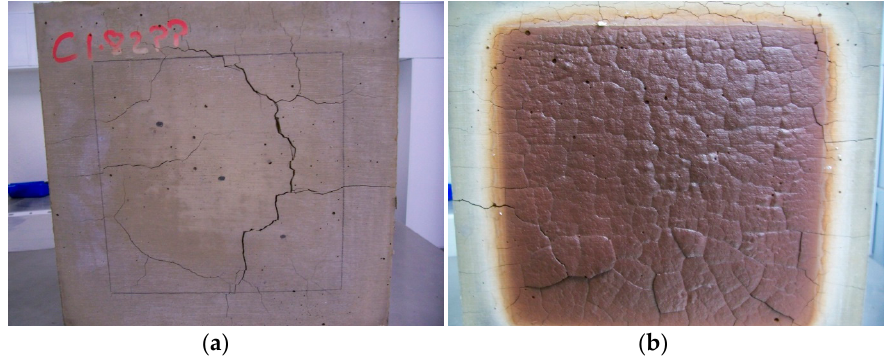
Figure 9. C1.82PP fire test image: ( a ) C1.82PP cold side after fire test; ( b ) C1.82PP hot side after fire test. Some evidence of crack healing is evident. Sample size is 300 mm × 300 mm with region exposed to heat being 200 mm × 200 mm.